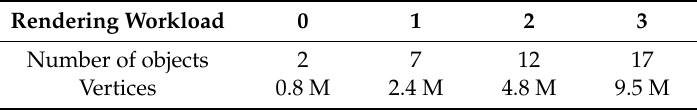
Table 4. Minimum, maximum, and average motion-to-photon latencies by different rendering